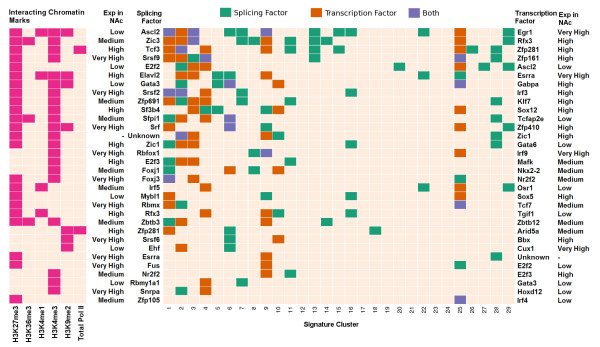
Splicing and transcription factors inferred from the 29 signature clusters induced by repeated cocaine and their interacting epigenomic marks. Splicing and transcription factors are indicated on the right panel by different colors. Green means the enrichment of a splicing factor on the left; red means the enrichment of a transcription factor on the right; blue means the enrichment of both. All 32 splicing factors and the top 32 transcription factors are shown here. Each column represents a signature cluster. The gene expression level for the regulators is labeled as 'Very High' (RPKM >20), 'High' (RPKM >5 and ≤20), 'Medium' (RPKM >1 and ≤5), and 'Low' (RPKM ≤1) based on our RNA-seq data. The chromatin marks that interact with the splicing factors are shown on the left panel by pink color.